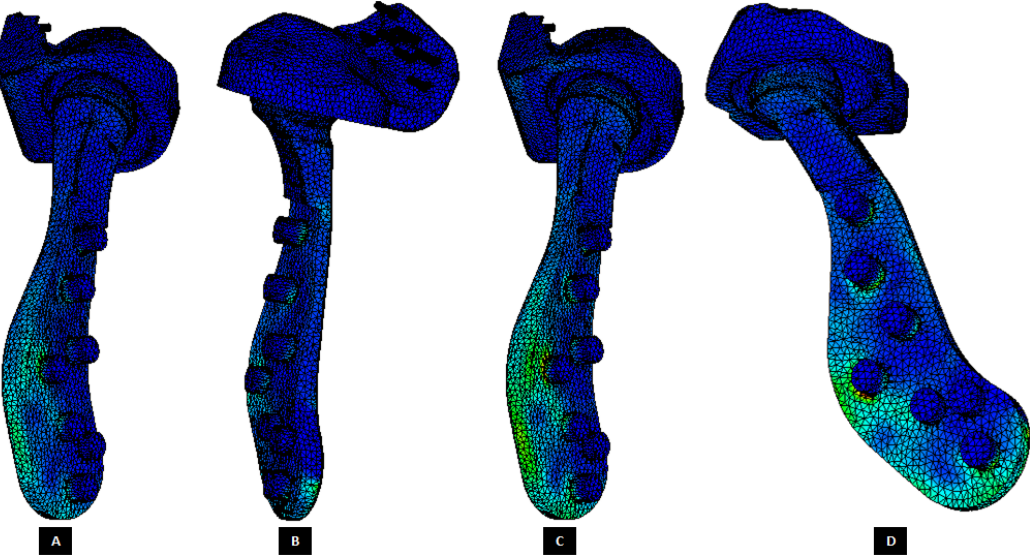
Figure 30. Peak von Mises stress in patient-specific ‘simple’ TMJ prosthesis (without notches) during FE simulations of two different loading scenarios. ( A , B ) Show von Mises total TMJ prosthesis under normal loading configuration. ( C , D ) Show von Mises stress profile in the prosthesis during FE simulation of worst-case/over-loading